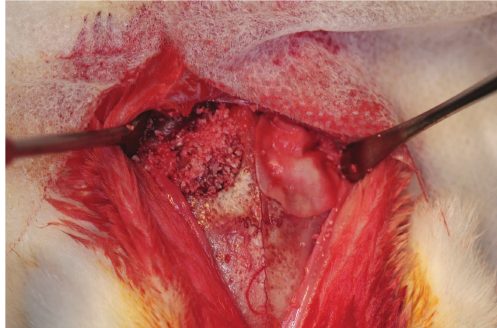
Figure 5: One of the parietal critical-size defects being protected with Bio-Gide